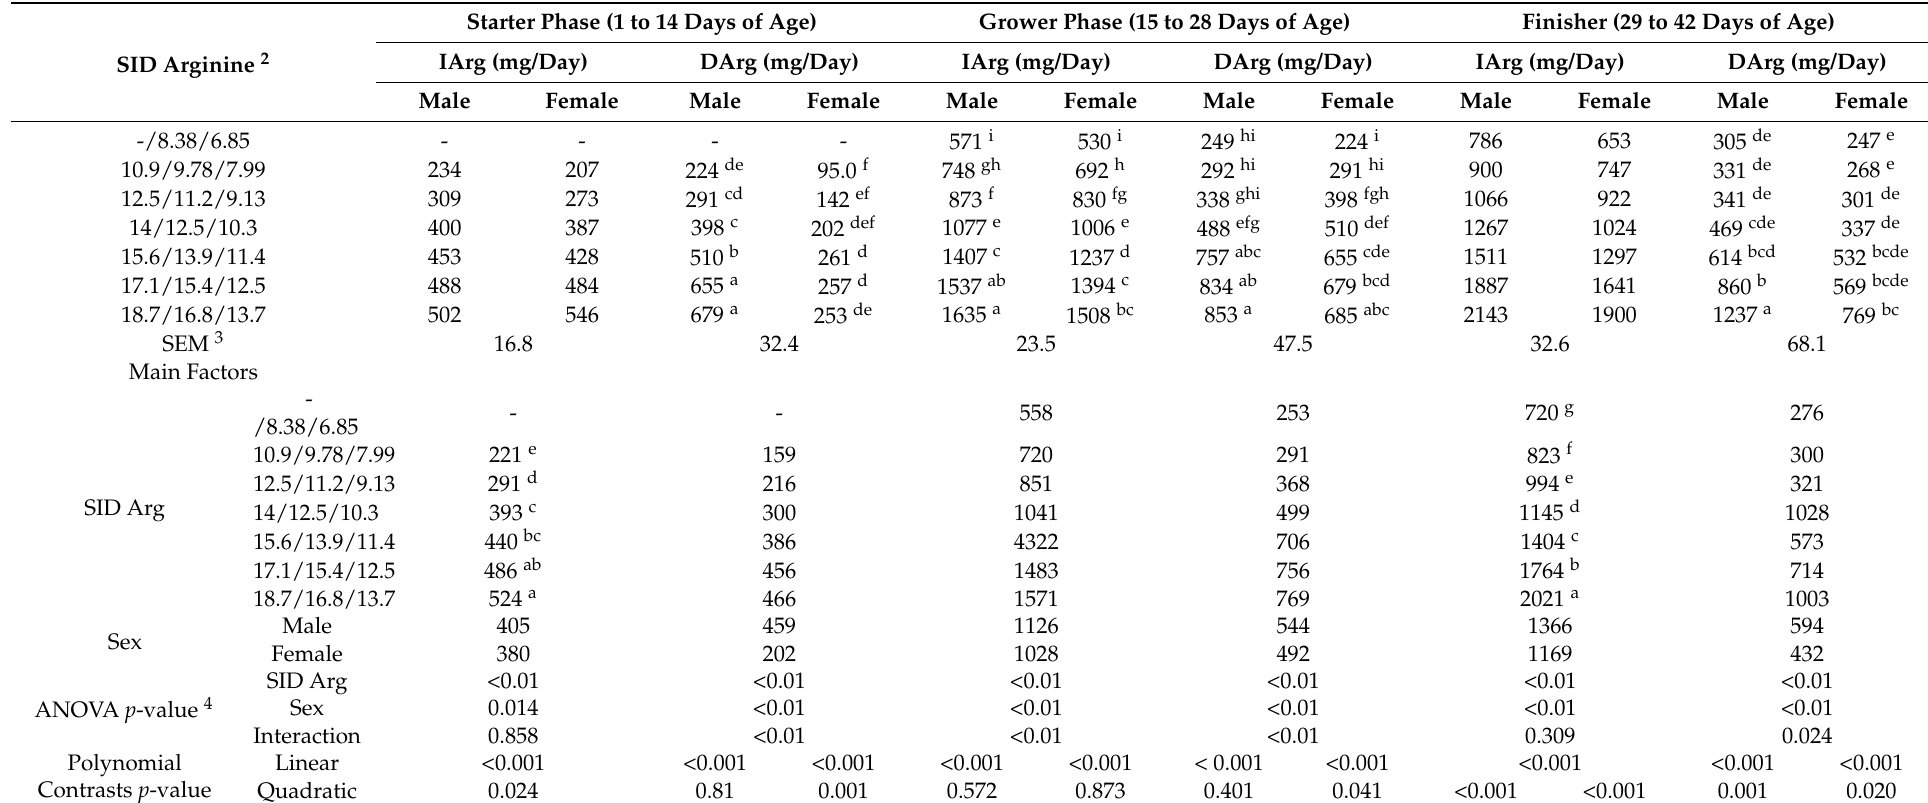
Table 6. Effects 1 of standardized ileal digestible levels Arg (SID Arg) in intake (iArg) and deposition on body and feathers (DArg) on male and female broiler chickens in the starter, grower, and finisher